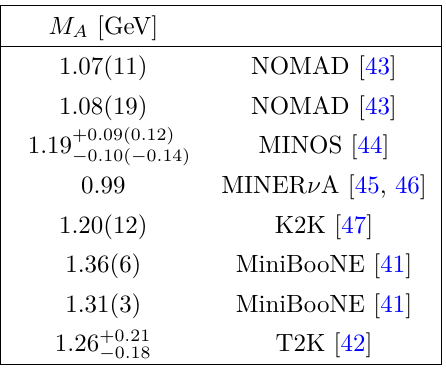
Table 1 . The axial mass M A as measured in a sample of recent neutrino